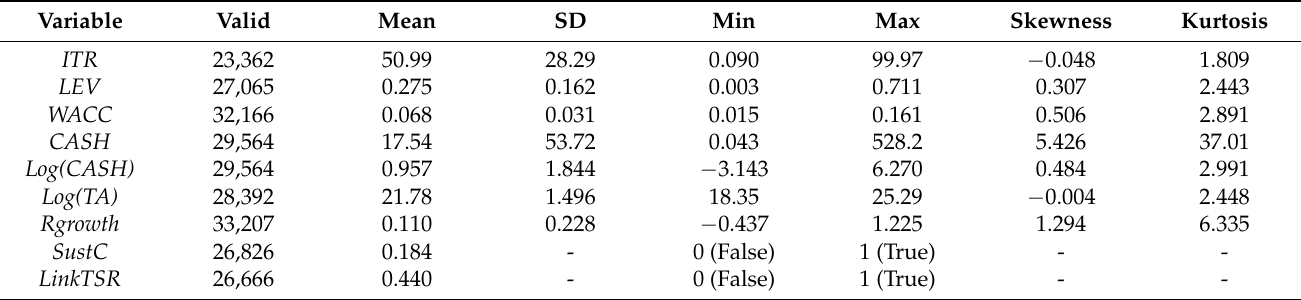
Table 3. Descriptive statistics for the financial ratios used in the